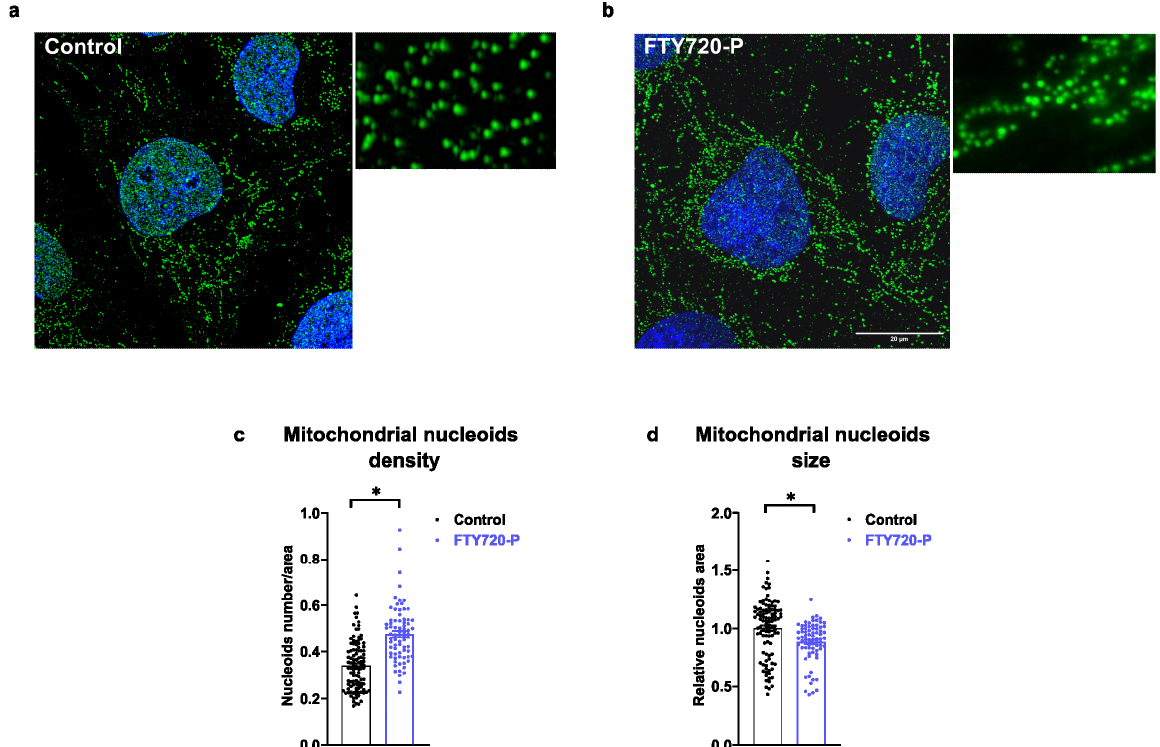
Figure 4. FTY720-P increases the number of mitochondrial nucleoids. AC16 cells treated with 100 nM FTY720-P for 48 h. Panels ( a , b ) show mitochondrial nucleoids stained with anti-DNA antibody (green) and visualized with SIM (super-resolution illumination microscopy). ( a ) Control AC16 cells incubated with the vehicle, ( b ) AC16 cells incubated with 100 nM FTY720-P. Nuclei were stained with DAPI (blue). ( c ) Quantification of mitochondrial nucleoid density is represented as mitochondrial nucleoids/cellular area; ( d ) mitochondrial nucleoid size. At least 30–50 cells/sample were counted in triplicate samples per condition and per experiment. Acquired images were processed with ImageJ software (NIH). Data were subjected to unpaired t -test. Data are mean ± SEM. * p -value ˂ 0.05 vs. control cells. Scale indicates 20 μ m.